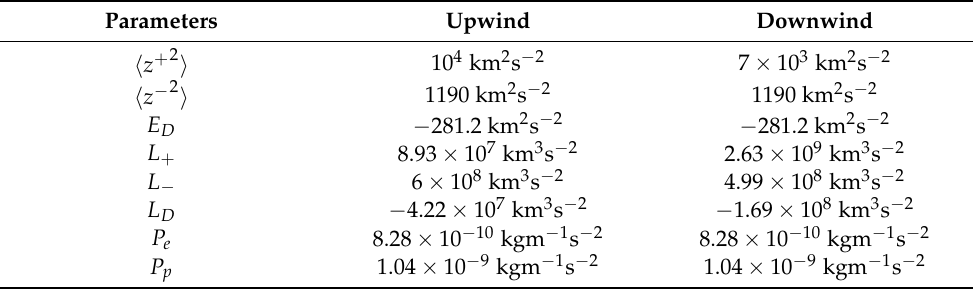
Table 1. Boundary values at 0.17 au for the upwind, and the downwind directions. The upwind boundary conditions are obtained from PSP measurements [19], and the downwind boundary conditions are chosen in such a way that the theoretical results closely reflect the measured values and observed trends of the Pioneer 10 data. We assume that the electron density is approximately equal to the proton density, n e ≈ n p .